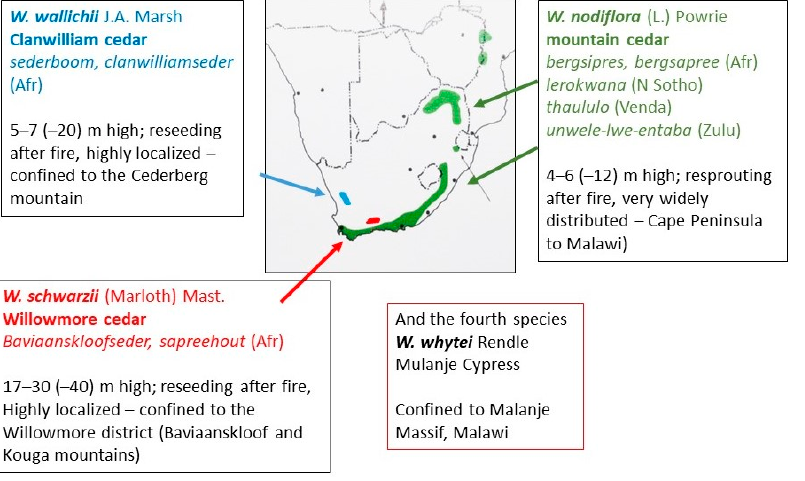
Figure 1. Distribution of the three species of Widdringtonia in South Africa.